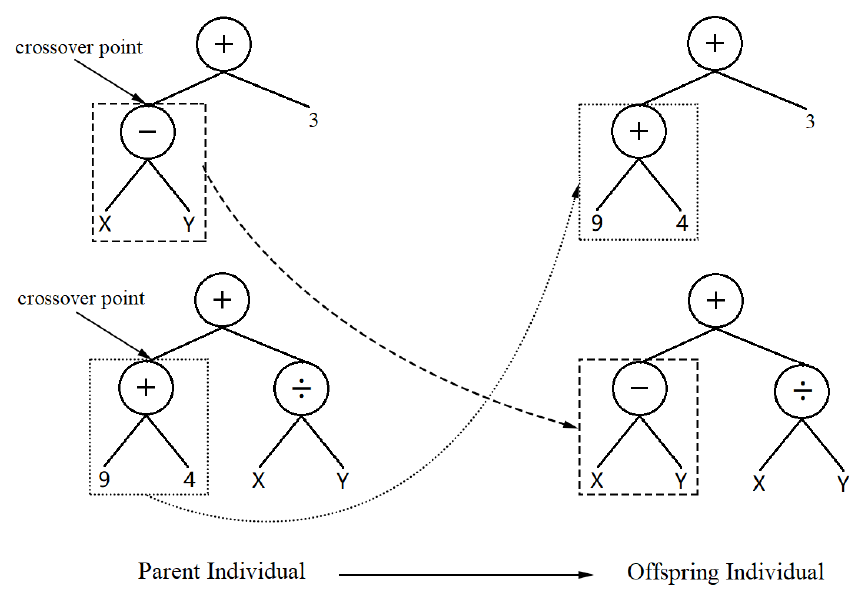
Figure 6. The crossover process of individual trees ( X − Y ) + 3 and ( 9 + 4 ) + ( X ÷ Y ) .